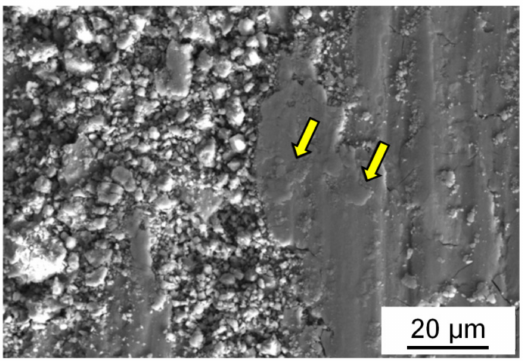
Figure 7. SEM image of the friction surface of HP-ed (Al–10Zn)–40Sn composite sample after dry friction against steel. P = 5 MPa; V = 0.6 m/s. Large delaminated wear particles that are pressed into the sample surface and form grooves on the counterbody surface are shown by arrows.